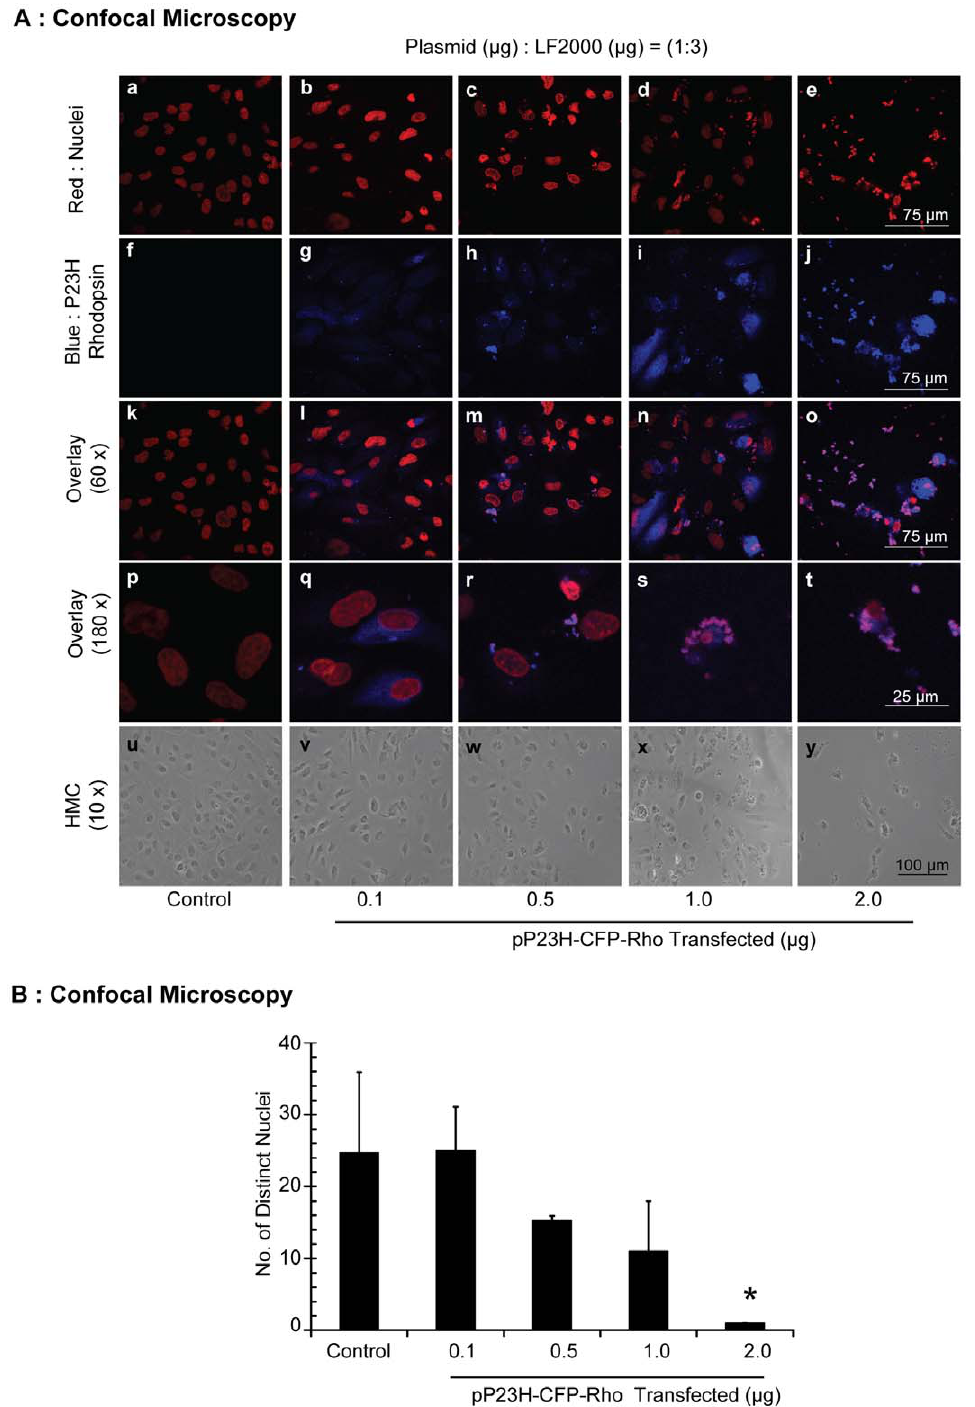
Figure 4. P23H rhodopsin disrupts the nuclear material and aggregates in RPE cells. A ) For confocal images, cells were fixed with 4% buffered formalin, permeabilized with 0.2% Triton X-100, and treated with RNase. The nucleus was then stained with TO-PRO-3 iodide. Confocal images were taken using the excitation/emission wavelengths of 637–605/75 and 408–450/35 nm for TO-PRO-3 iodide and CFP, respectively. Representative images from one of the three independent studies have been shown. For HMC images, the cells were visualized using Nikon inverted light microscope at 10x magnification. B ) The number of distinct nuclei was counted in each confocal image from three independent studies and was plotted against the pP23H-CFP-Rho transfection level. Data is expressed as mean 6 S.D. for N=3. *, p , 0.01 compared with LF2000 transfected (control) group.